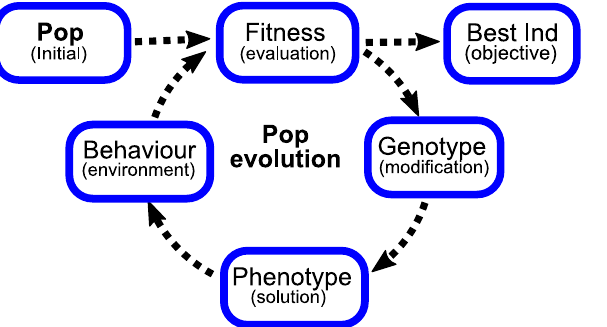
Figure 2. General representation for an evolutionary robotics process with four levels of organization: (1) genotype, (2) phenotype, (3) behavior, and (4)